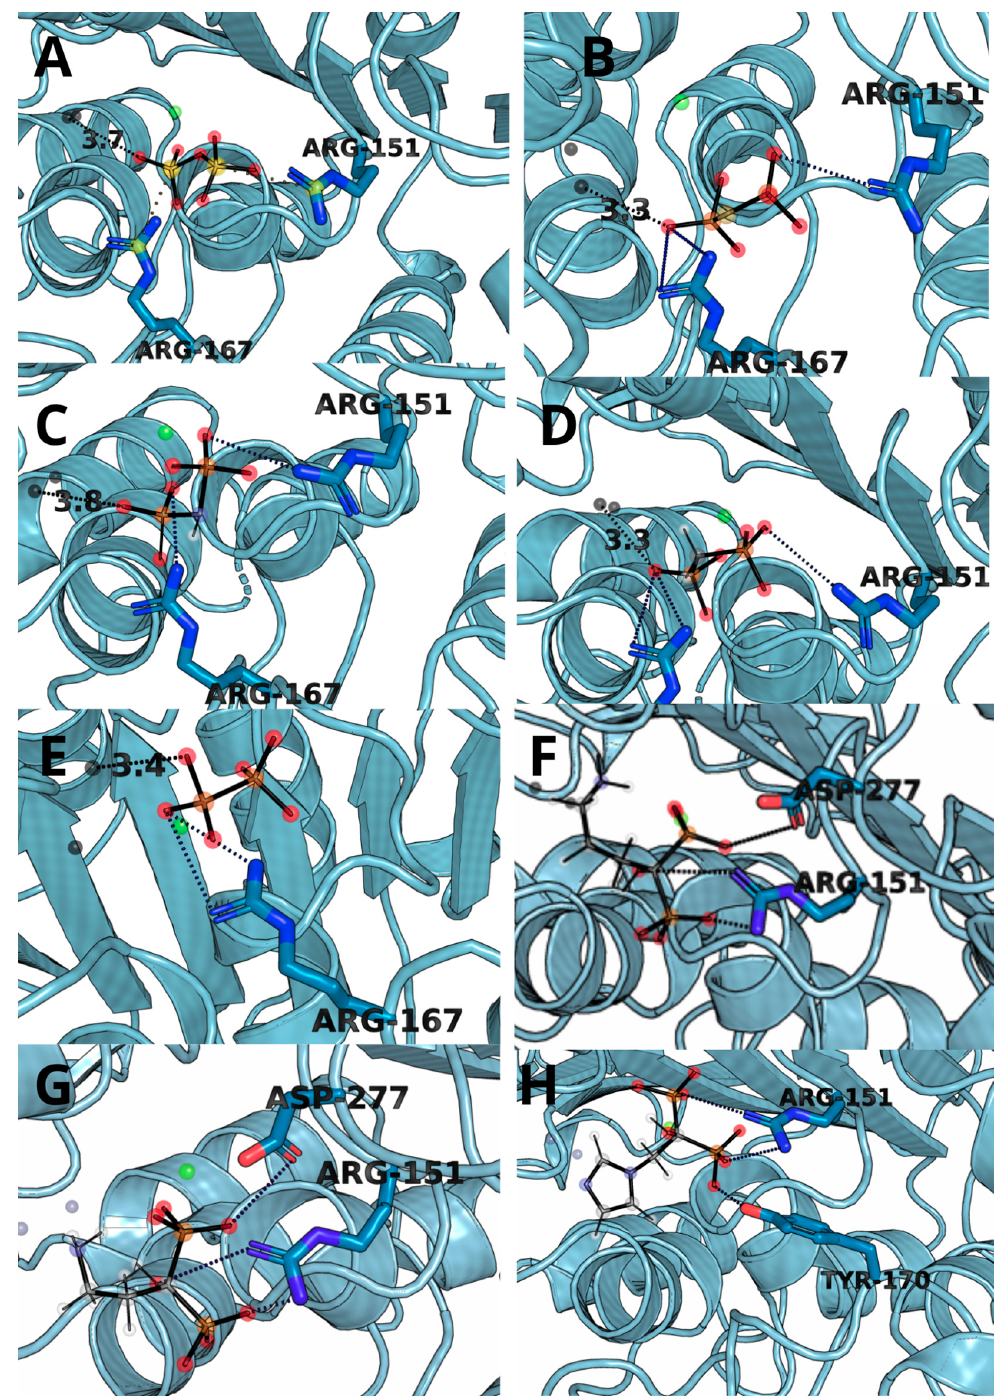
Figure 3. The structure snapshots for TNAP active site with ligands: ( A ) pyrophosphate, ( B ) monothiopyrophosphate, ( C ) imidodiphosphate, ( D ) methylenediphosphonic acid, ( E ) hypophosphate, ( F ) alendronate, ( G ) pamidronate and ( H ) zoledronate.